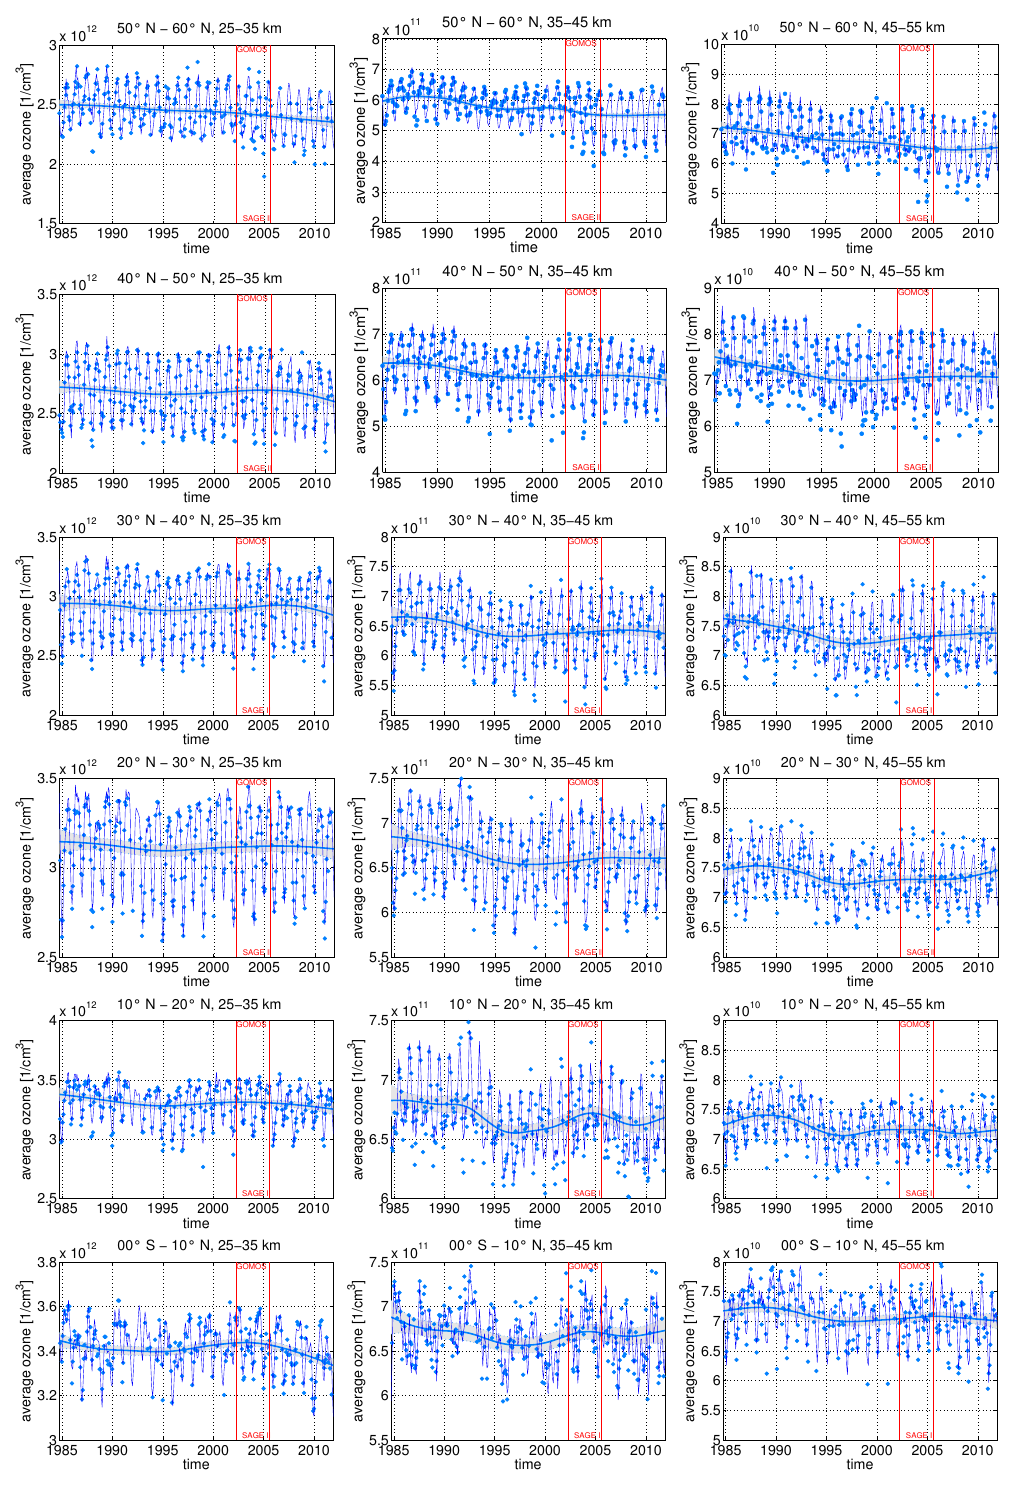
Figure 6. All fits collected for the Northern Hemisphere. The three altitude regions as columns, Northern Hemisphere 10 ◦ zonal bands as rows starting from the northernmost zone. The smooth solid curve shows the estimated background level with 95% probability envelope. The dots are the observations used in the analysis. The solid line following the observations is the DLM fit obtained by Kalman filter formulas.